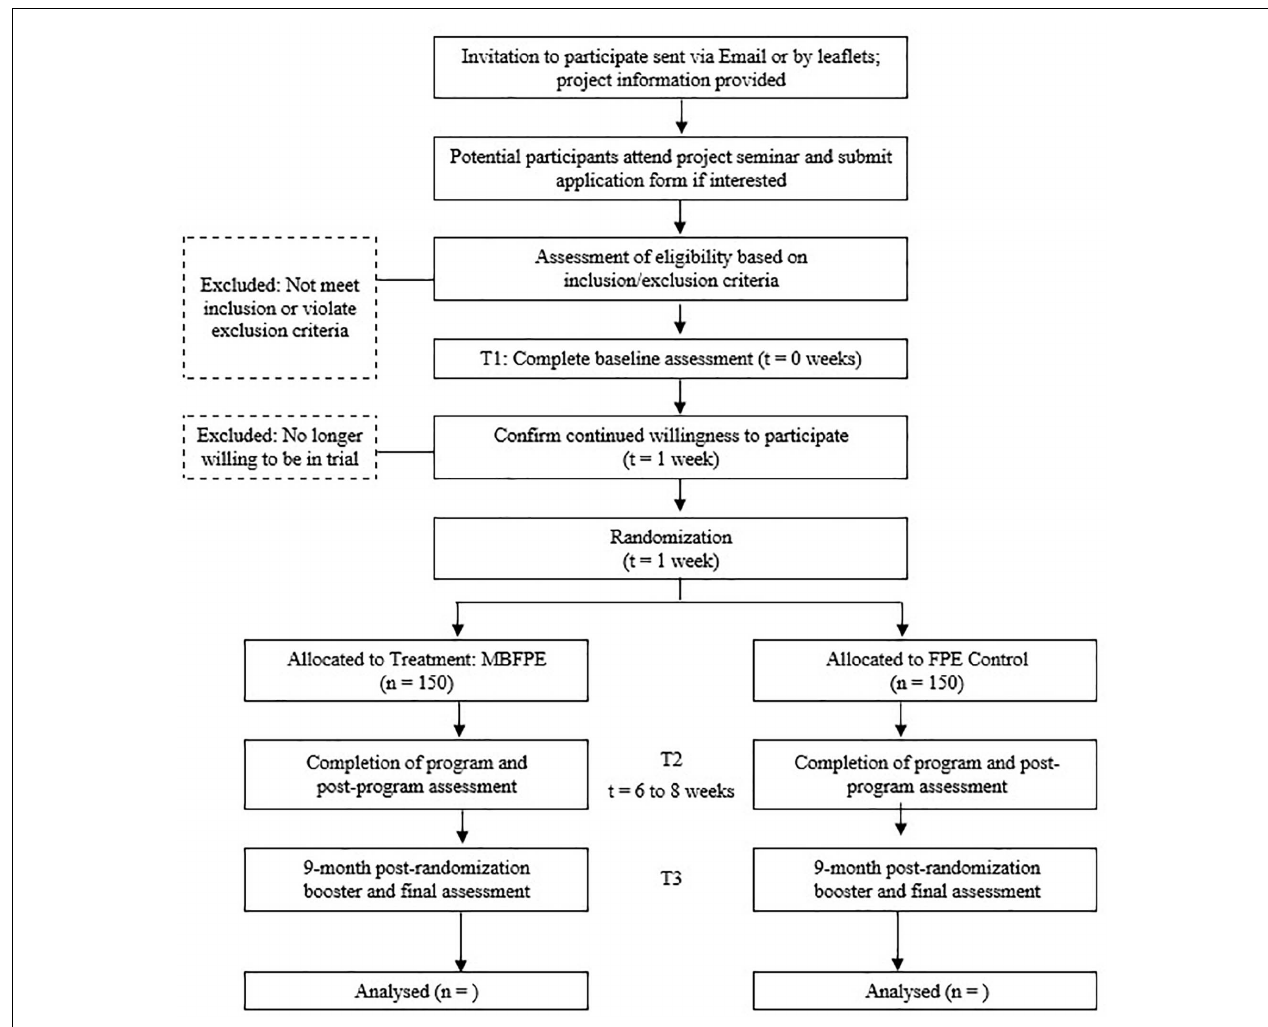
FIGURE 1 | Flew diagram of participant